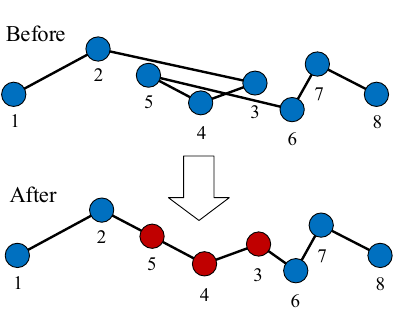
Fig. 3. 2-opt operator to remove algorithm restart the search from the first node. If the new trajectory is not better, the search continues to the next node. The algorithm is implemented as two nested loops and the search restarts when a better solution is found. The details of the 2-opt algorithm is covered in [21].